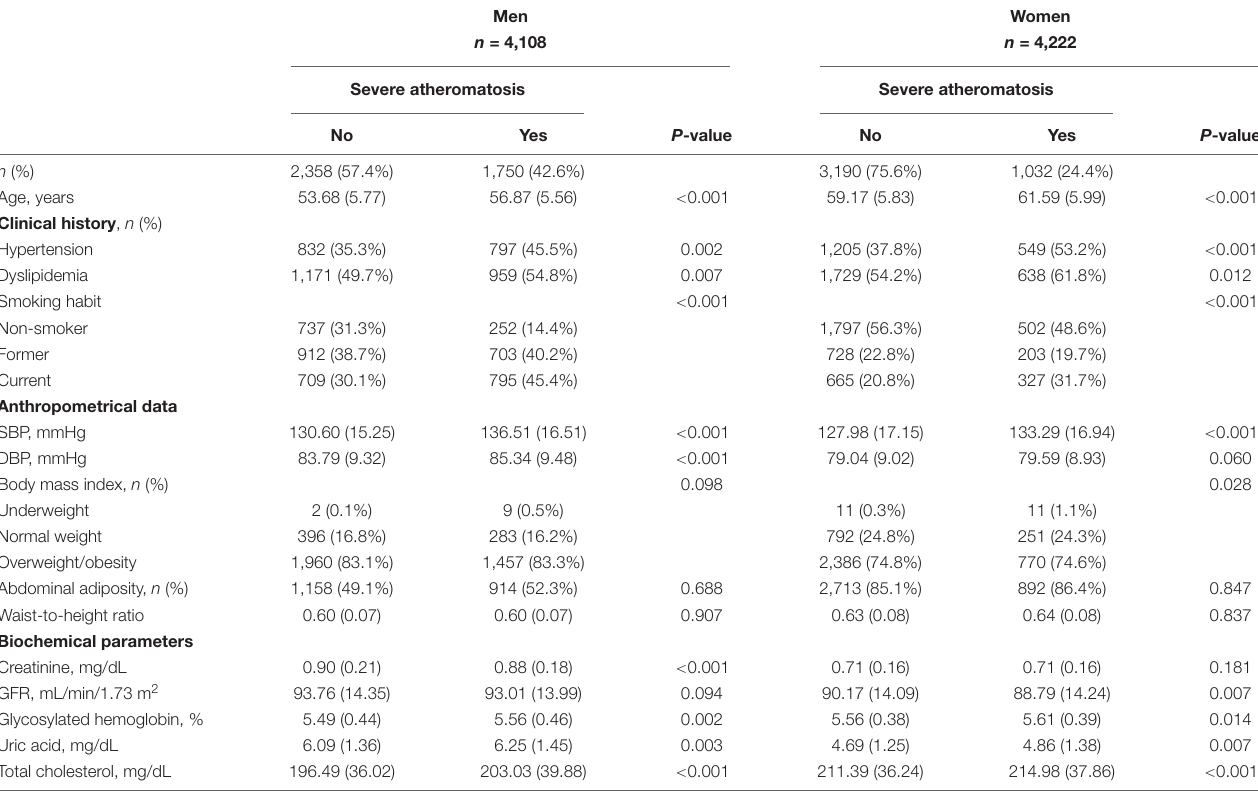
TABLE 1 | Baseline characteristics of the ILERVAS cohort by sex.